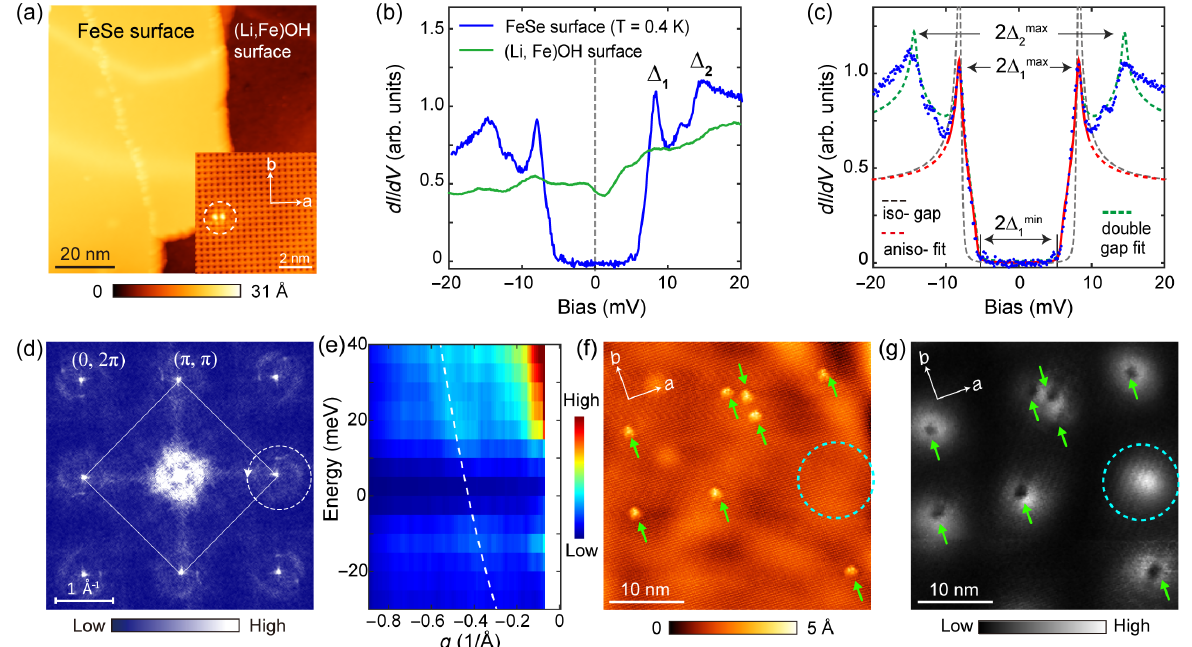
Þ OHFeSe film. (a) Topographic image of a cleaved Fe 0 . 84 . 16 Þ OH surface at 4.2 K Fe 0 . 84 . 16